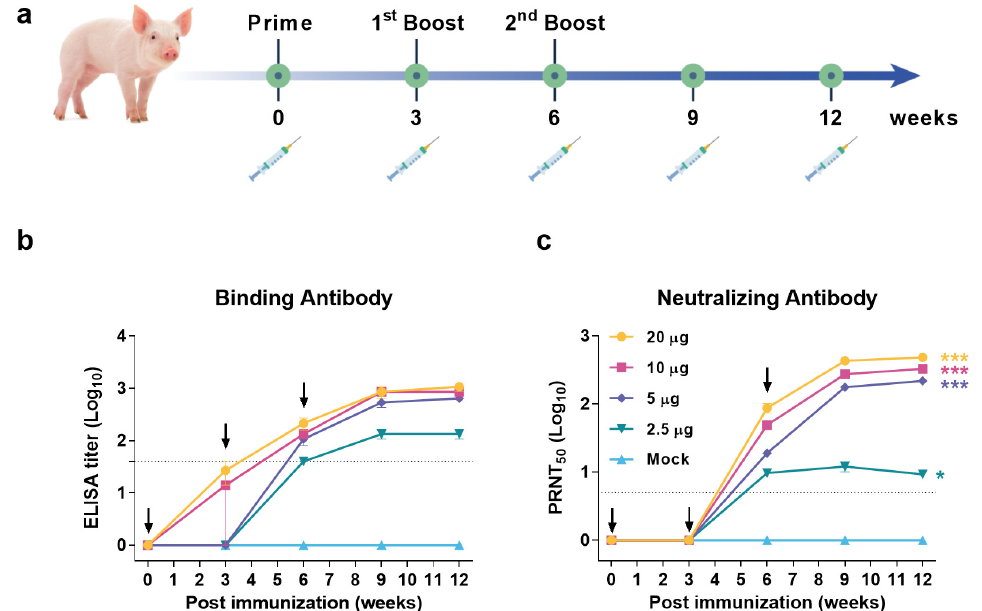
Figure 4. Humoral immune response elicited by different doses of JEV VLP in pigs. ( a ) Flow chart of JEV VLP immunogenicity evaluation in pigs. Groups of 4-week-old pigs were immunized three times by IM route with 2.5 µ g, 5 µ g, 10 µ g, or 20 µ g JEV VLP, or PBS as control. Solid vertical lines indicate weeks of immunization (black), and syringe symbols indicate blood sampling time points. ( b ) JEV specific binding antibodies were assessed by ELISA. ( c ) Neutralizing antibodies against JEV SA 14-14-2 strain were measured by PRNT assay. Dotted lines indicate detection limit. Data are shown as means ± SEM. NAb differences between immunized and control groups were analyzed by Tukey–Kramer multiple comparison test. (*, p < 0.05; ***, p <